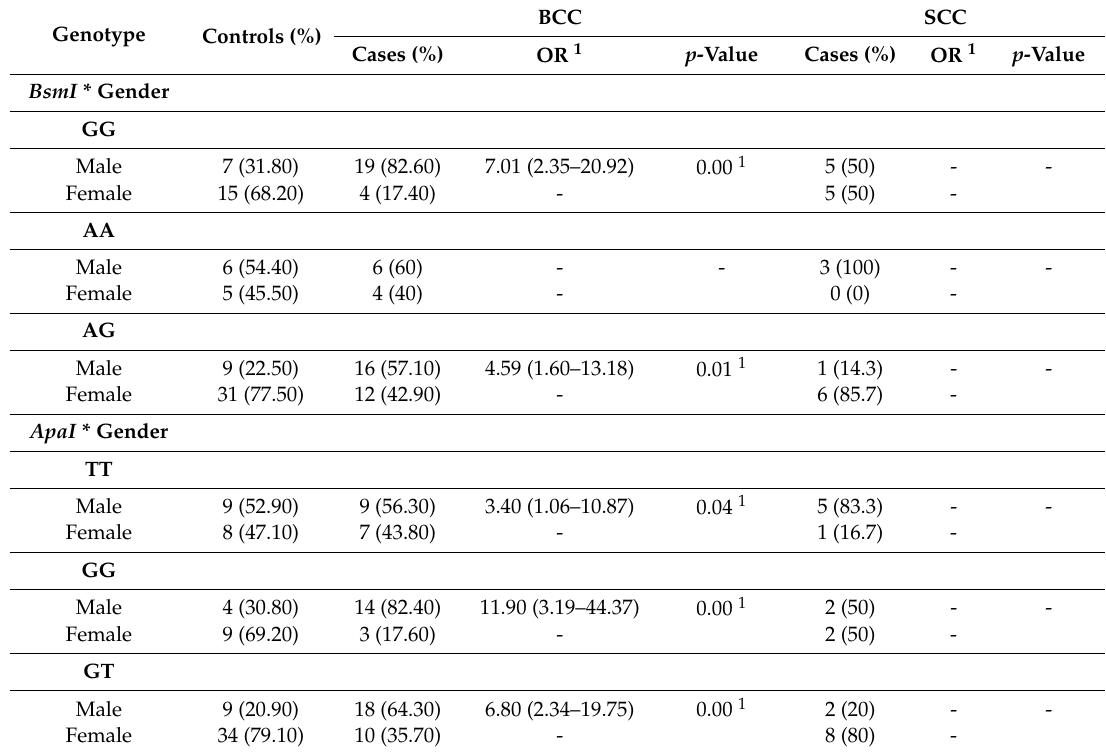
Table 2. BsmI and ApaI polymorphisms for stratum gender and skin cancer